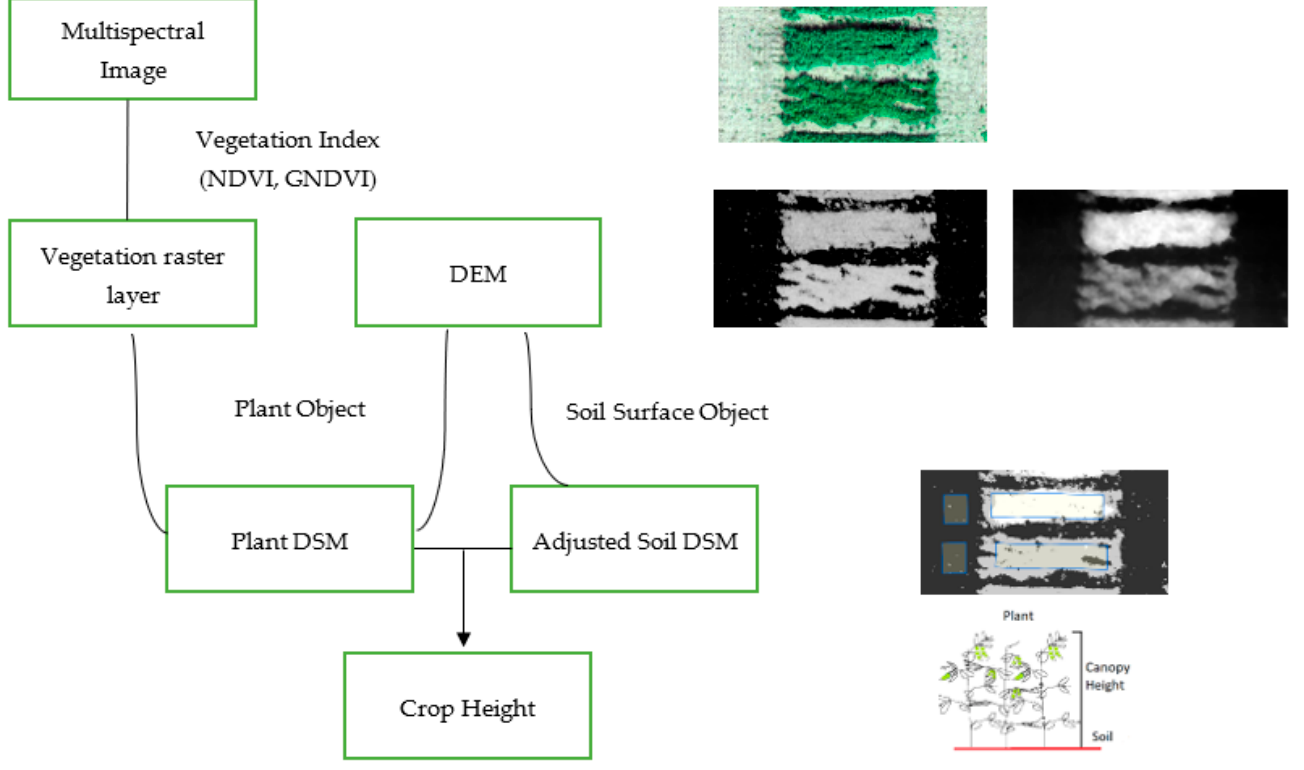
Figure 1. Workflow of canopy height extraction. Steps of image processing with the functions: 1. Use vegetative index threshold the image to derive the plant pixel mask. 2. Extract plant digital surface map (DSM) from the DEM, plant polygons and plant mask. 3. Extract soil DSM from the DEM and soil polygons. 4. Calculate the normalized canopy